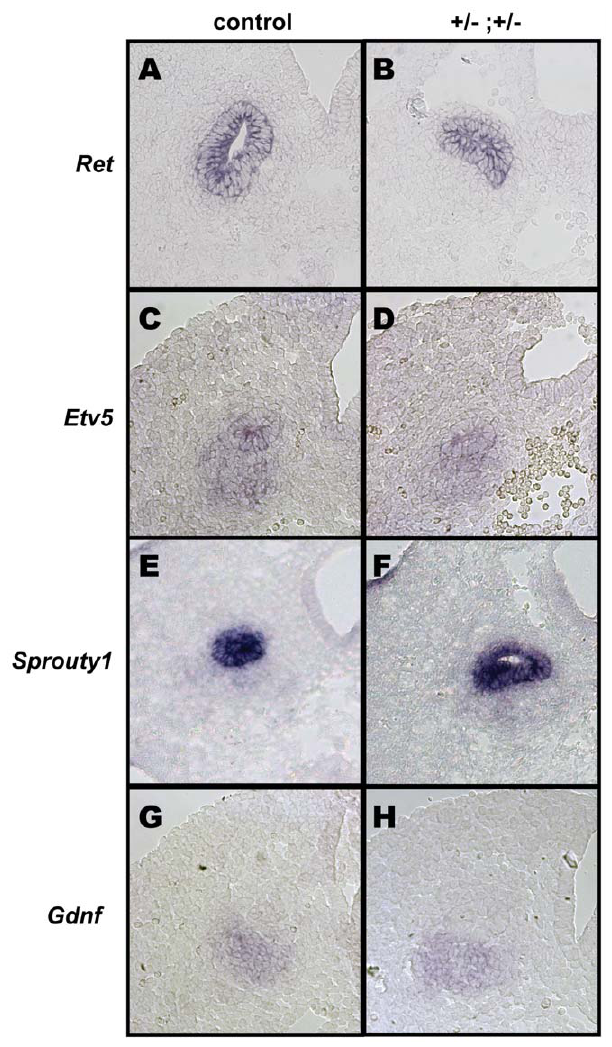
Figure 4. Unaltered expression of ureter budding regulators in Pax2 + / 2 ;Emx2 + / 2 embryos. In situ hybridization for the main regulators of budding at E10.5 reveals no significant difference in mRNA expression between controls (A,C,E,G) and Pax2;Emx2 compound heterozygous embryos (B,D,F,H). (A,B) Ret , (C,D) Etv5 , (E,F) Sprouty1, (G,H) Gdnf .